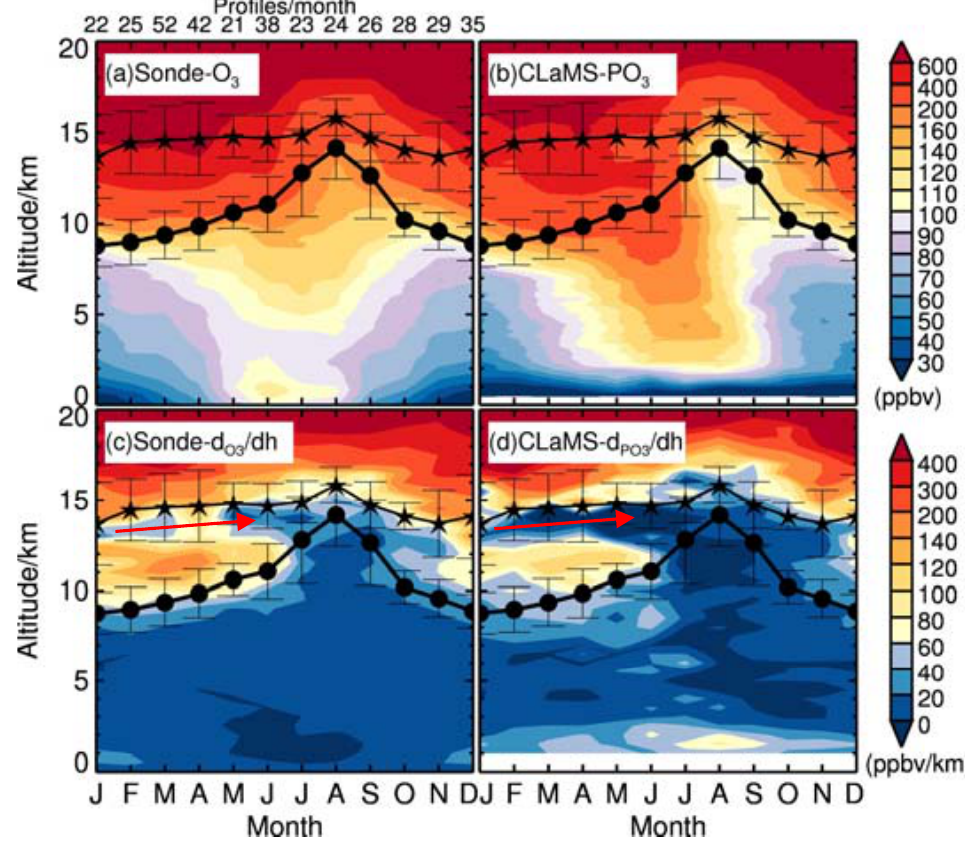
Fig. 2. The seasonality of ozone from (a) ozonesonde observation, (b) CLaMS-PO 3 (passively transported ozone) from CLaMS simulation at the time and location of the measurement, and their corresponding (c, d) vertical gradients during 2002–2010 at Beijing. The first (LRT1) and second (LRT2) thermal tropopauses are shown as a thick line with solid dots and stars, respectively. The error bars are standard deviations ( ± σ) . The red arrow shows a thin layer with a reduced ozone gradient below LRT2.